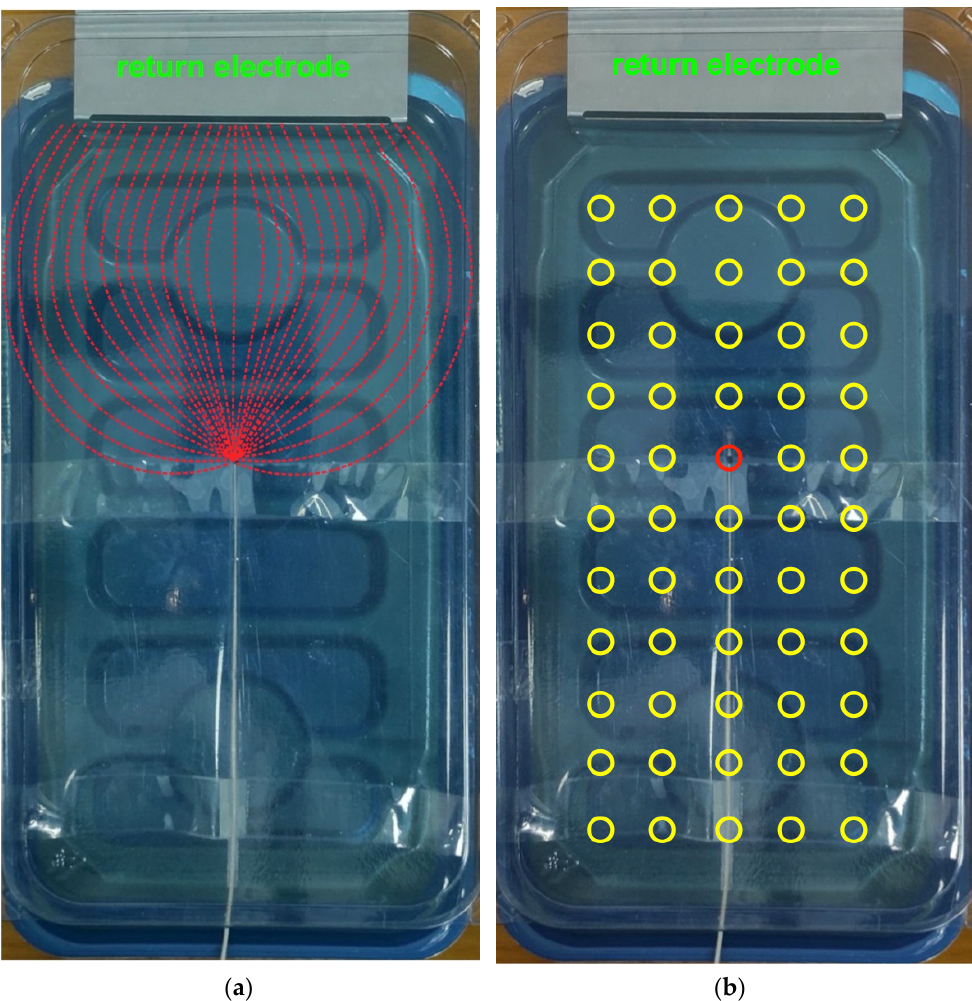
Figure 5. Measurement setup for the test on the electrocatheter in the saline solution. ( a ) The red dashed lines represent the main ionic current lines between the electrocatheter electrode and the return electrode; ( b ) the yellow circles correspond to the measurement points. The catheter electrode corresponded approximately to the red circle in position (3,5).